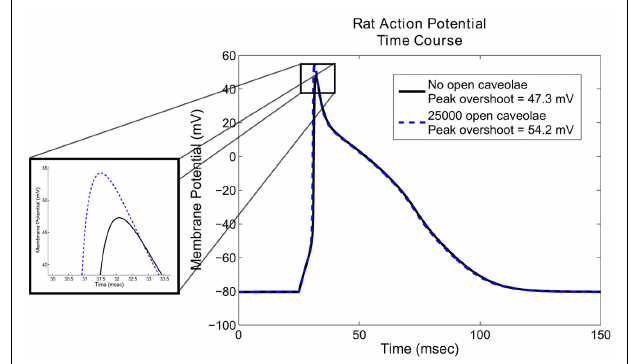
FIGURE 3 |Action potential morphology using the Pandit et al. (2001) model with and without caveolar sodium current. Notice that the inclusion of 25,000 open caveolae results in an approximately 5.4% increase in peak overshoot of the action potential. Less evident from the graph is a 29% increase in maximum upstroke velocity, an important factor in determining the speed of the excitatory wave through the cardiac tissue. Action potential duration, is relatively unaffected by the additional sodium conductance introduced by the open